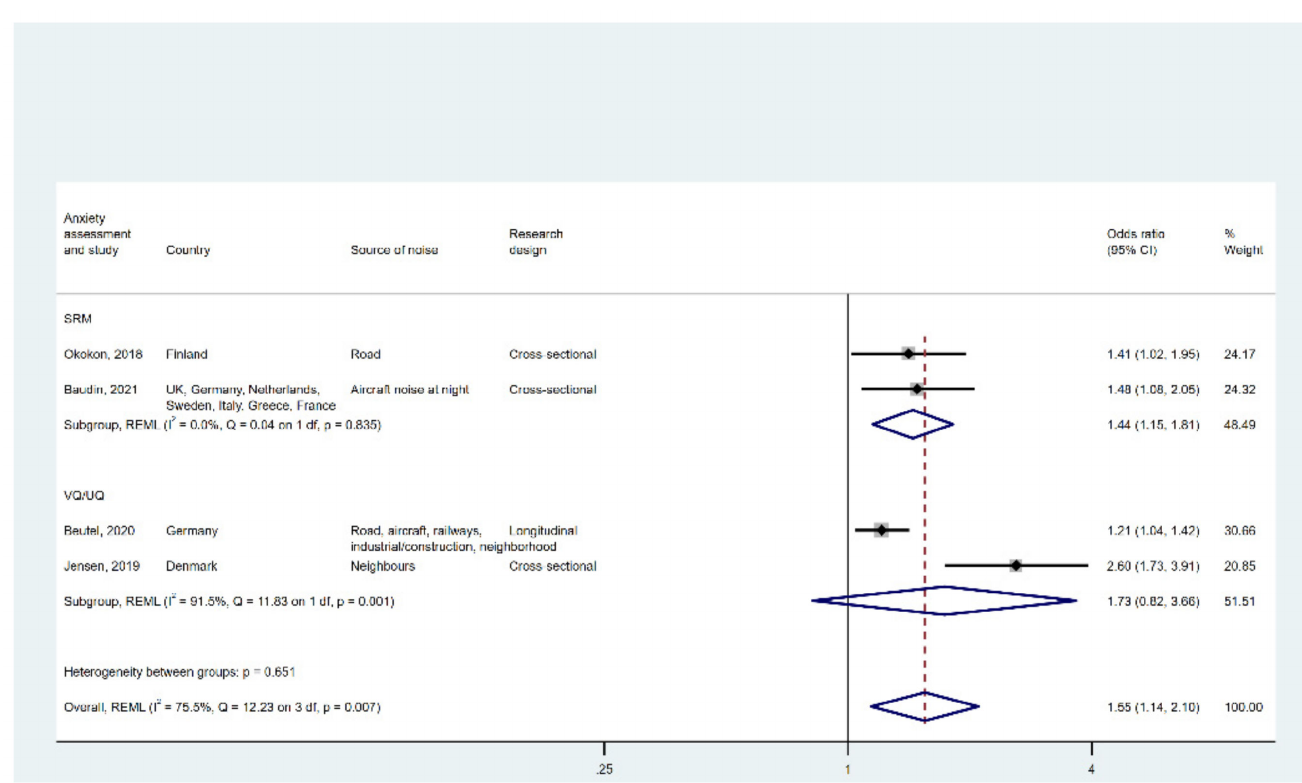
Figure 3. Forest plot displaying the link between high noise annoyance and anxiety disorder. Note: weights and between-subgroup heterogeneity text are from random-effects